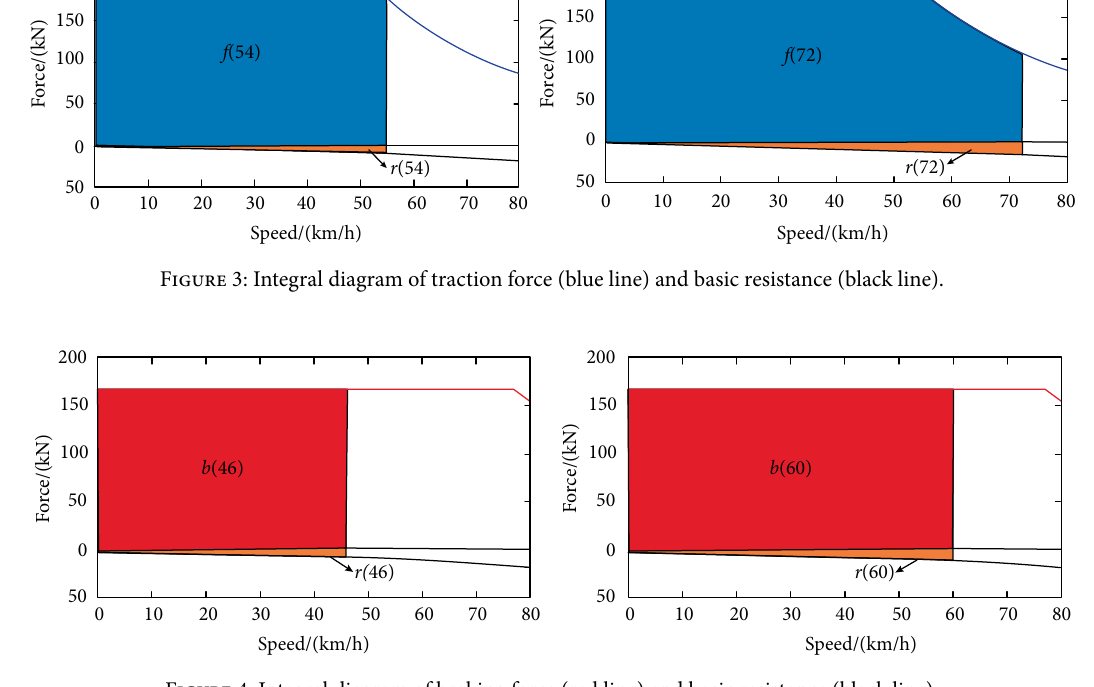
Figure 4: Integral diagram of braking force (red line) and basic resistance (black